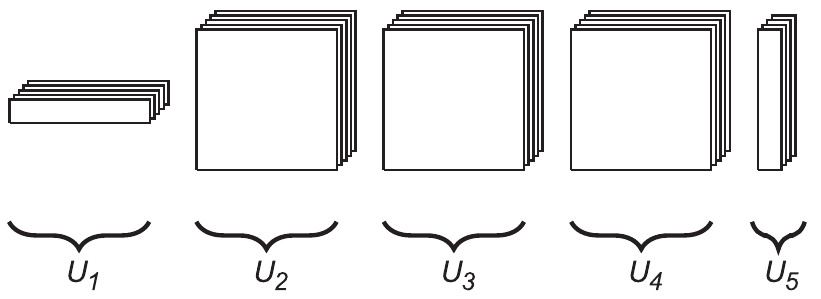
Figure 1. Schematic drawing of a TT decomposition of a five-dimensional array. Each TT core can be visualized as a stack of matrices with the size of the stack equal to the corresponding mode size. The number of TT cores is equal to the number of dimensions of the array. Element u ( j 1 , ... , j 5 ) of the full array is given by the (matrix) product of matrix j 1 selected from core U 1 , matrix j 2 from core U 2 , etc. Note that the size of each matrix within a core must be the same, but may differ between distinct cores. Note also that the number of matrices in each core depends on the corresponding mode size of the full tensor and generally differs between cores. Such an interpretation in the sense of a product of parametric matrices is widely used for the Matrix Product States , see [46–48].